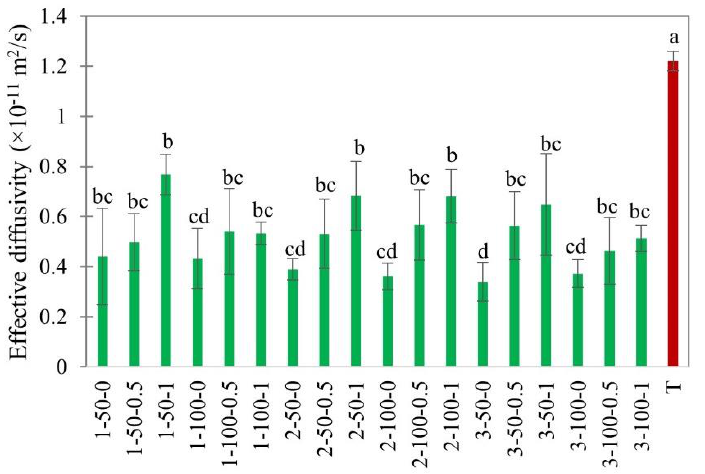
Figure 7. Effective diffusivity of EHD (marked in green and labeled as thickness-slice load density- airflow) and hot air-dried (marked in red as T) apple slices. Different lower-case letters indicate statistically significant differences ( p < 0.05).